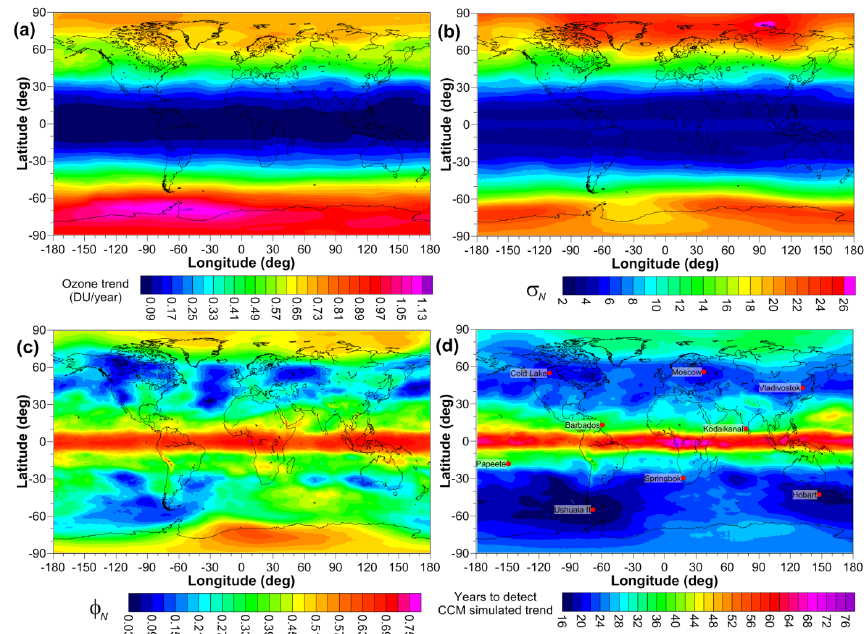
Figure 10. (a) Total column ozone trends in DU per year obtained from median values of trends calculated from 21 CCM projections of ozone over the period 2010 to 2050, (b) the standard deviation in regression model residuals in monthly mean total column ozone calculated from the Bodeker Scientific total column ozone database, (c) the first-order autocorrelation coefficient of the residuals, and (d) the number of years required to detect the expected total column ozone trends displayed in (a) . Also shown in (d) are selected locations which are at least 6000km apart but sample regions of short periods to detect expected trends.